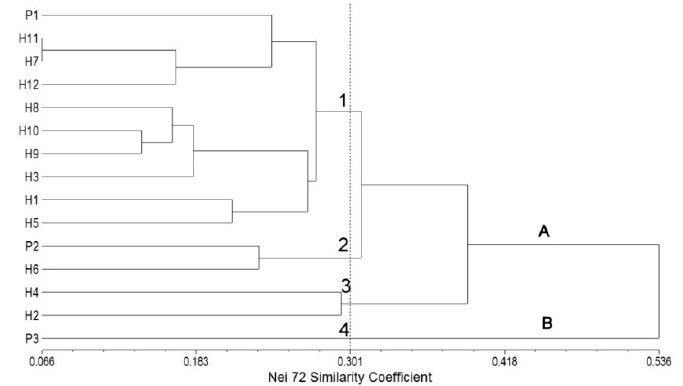
Figure 3. UPGMA dendrogram of Streptocarpus parents and F1 based on Nei72 ′ s similarity coefficient.